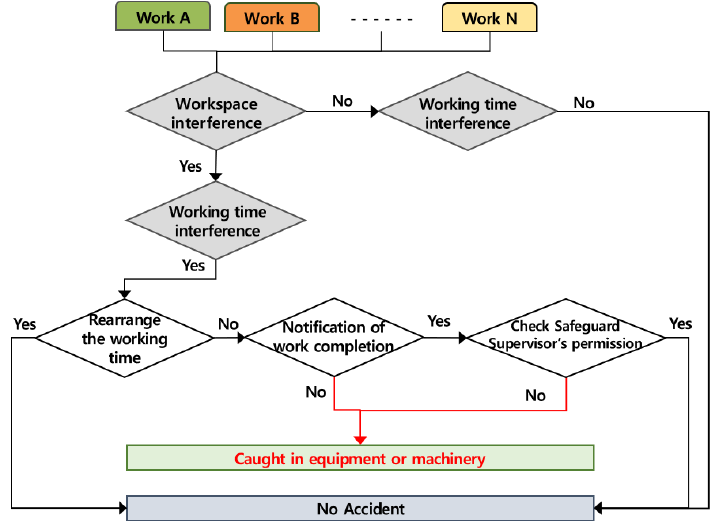
Figure 5. Mechanism of being caught in equipment or machinery by multiple processes in the work- place (AMMP